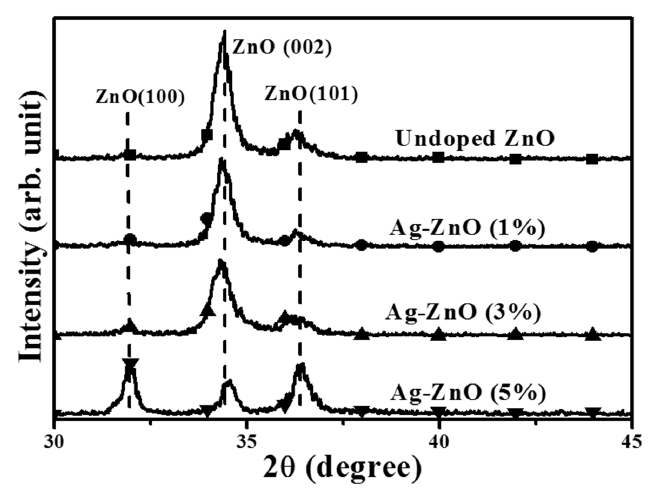
Figure 3. XRD patterns of the undoped ZnO and the co-sputtered Ag-ZnO films at the theoretical Ag atomic ratios of 1%, 3%, and 5%, respectively, after annealing at 350 °C for 1 h under ambient air.